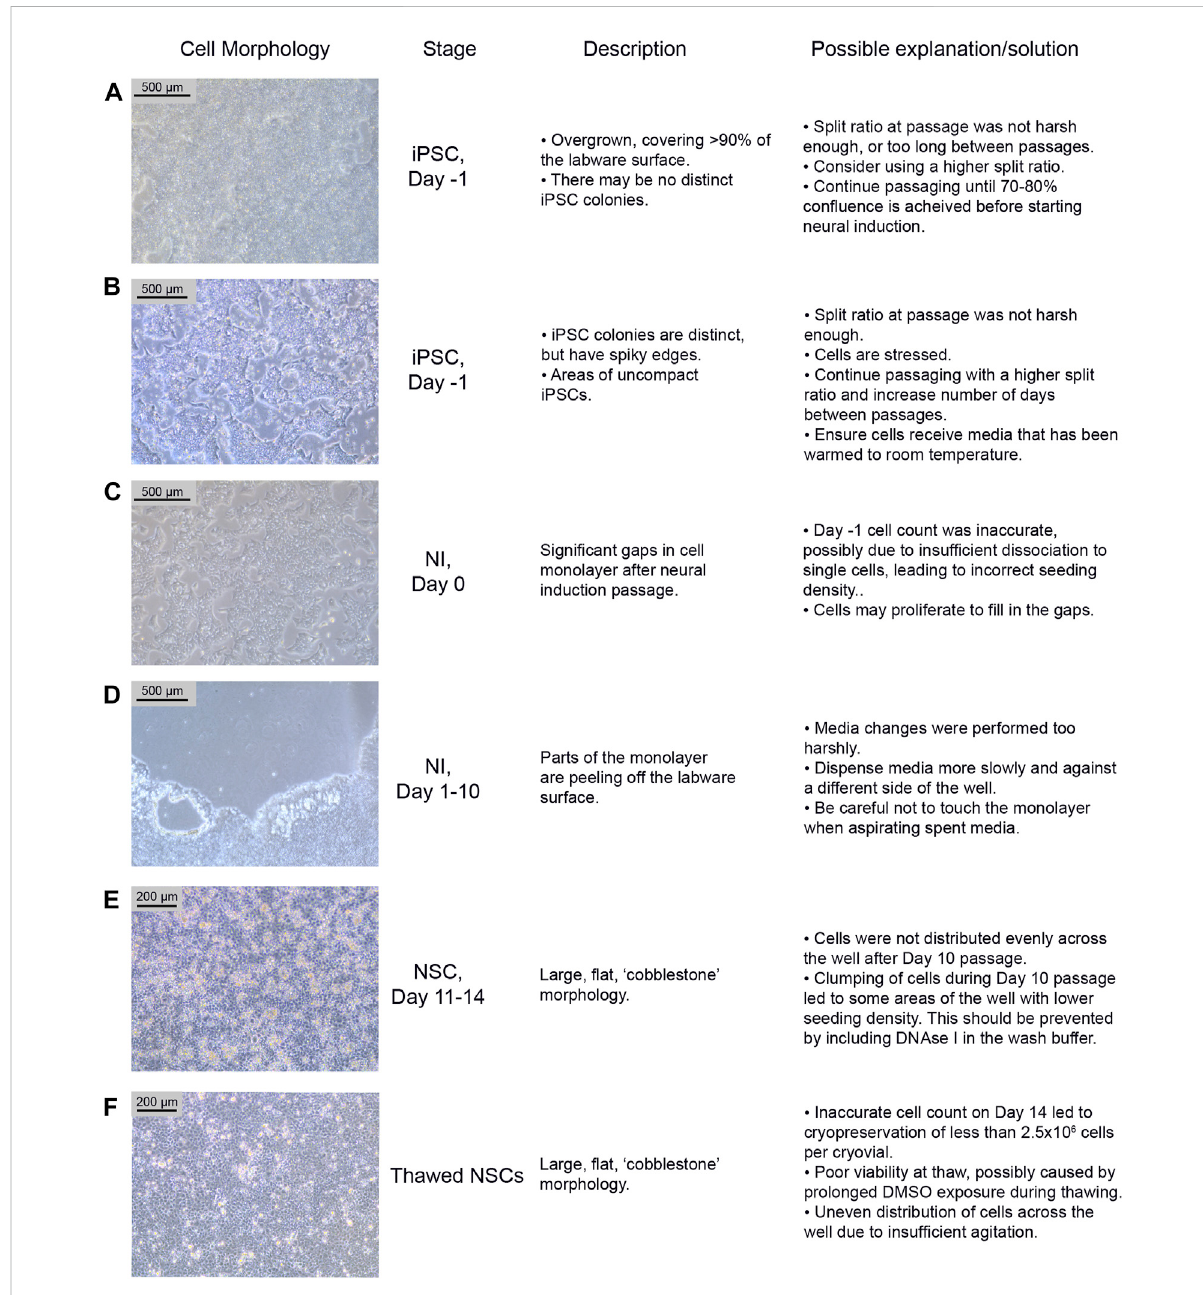
FIGURE 3 Common differentiation problems. Examples (A – F) of common issues at different stages of neural differentiation, their morphological appearance, possible explanations as to why they may occur, and potential corrective actions. NI: Neural Induction stage.